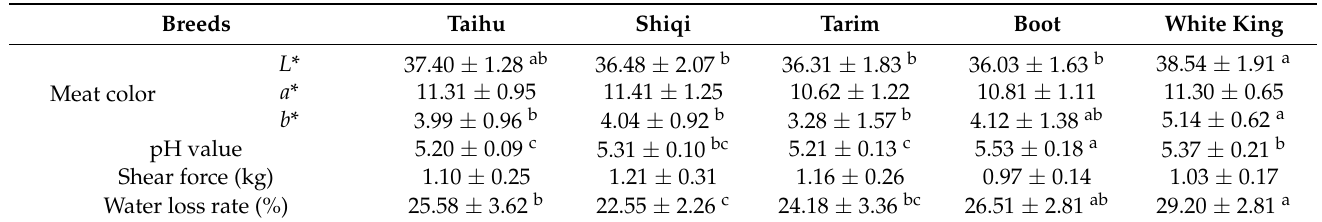
Table 1. Comparison of basic meat quality parameters between different breeds of pigeons.